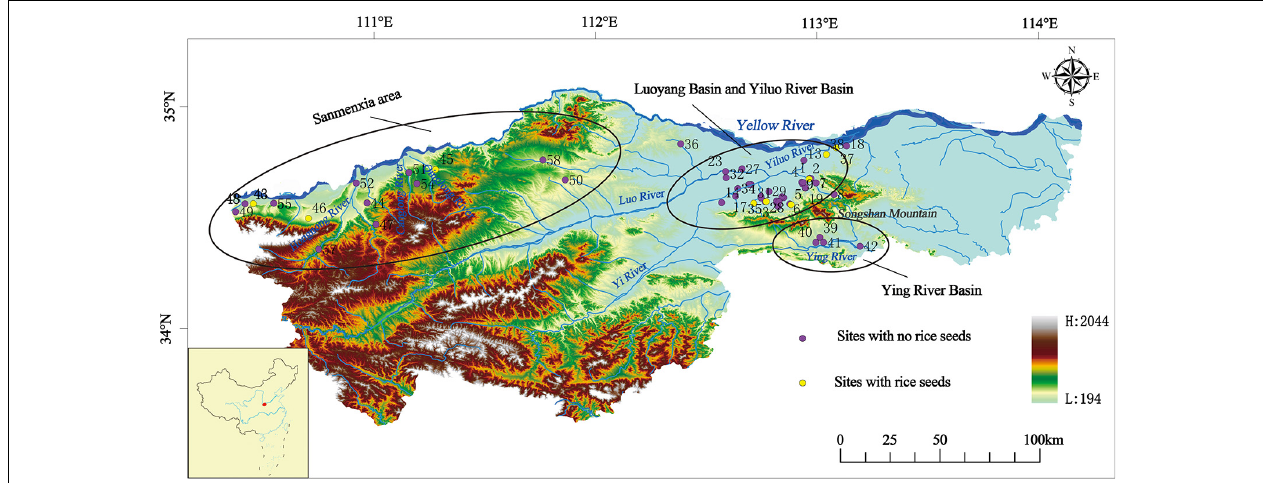
FIGURE 1 | Sites in central and western Henan Province from which remains of carbonized plants belonging to the Yangshao Culture were collected for this study. Weizhuang; 2. Weizhuang south bank of southwest River; 3. Xiqijiayao; 4. south of Yulinzhuang; 5. Zhaocheng; 6. southwest of Zhaocheng; 7. Wuluo Reservior; 8. Shangzhuang; 9. Tianpo; 10. north of Huacheng River; 11. Peicun; 12. Sanggou; 13. Nanwayao; 14. Jiuliugou Reservoir; 15. Bucun; 16. Beizhai; 17. Gongjiayao; 18. Fuxitai; 19. Tidong; 20. Longgudui; 21. Laozhouzhai; 22. Dongguanmao; 23. Xishiqiao; 24. Gaoya; 25. west of Gaoya; 26. Yulinzhuang; 27. Jingyanggang; 28. Huizui; 29. Tunzhai; 30. Waizhuang; 31. Zhaiwan; 32. Jinzhongsi; 33. Mazhai; 34. Jueshan; 35. Fujiazhai; 36. Bangou; 37. Shuanghuaishu; 38. Wanggou; 39. Yangcun; 40. Yuanqiao; 41. Yuancun; 42. Shiyangguan; 43. Didong; 44. Xiaowu; 45. Nanjiaokou; 46. Xipo; 47. Chengyan; 48. Dongqiao; 49. Dongshe; 50. Duzhong; 51. Lucun; 52. Mengcun; 53. Nanyuan; 54. Renmazhai; 55. Shangmotou; 56. Sigeda; 57. Yanzhuang; 58.